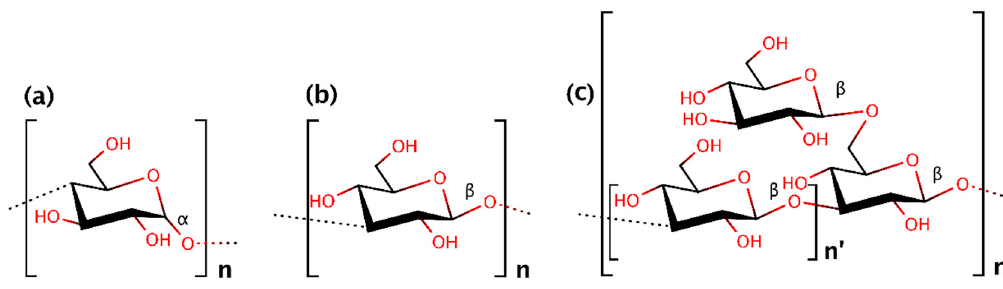
Figure 1. Chemical structure of fungal glucans. ( a ) α -(1,4) glucan, ( b ) β -(1,3) glucan, ( c ) β -(1,3) glucan with β -(1,6) side chain.